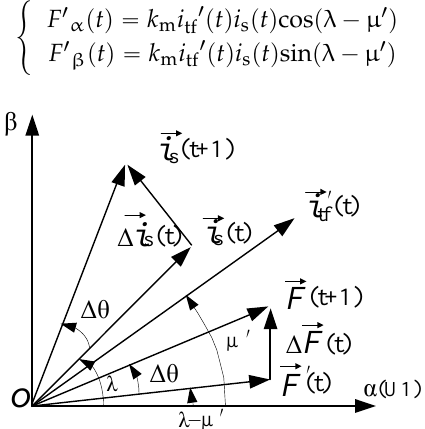
Figure 7. The relationship between the increment of suspension force and the suspension force current. There is a proportional relationship between the variation of suspension force and the variation of suspension force current. The difference between them is 1/ K m i ′ tf ( t ) times according to geometry knowledge shown in Figure 7. The angle should be computed as λ − (λ − μ′) = μ′ which is the same as the angle between vector i ′ tf ( t ) and vector F ′( t ). Assuming suspension force command is F ( t + 1) at moment t + 1, as follows: